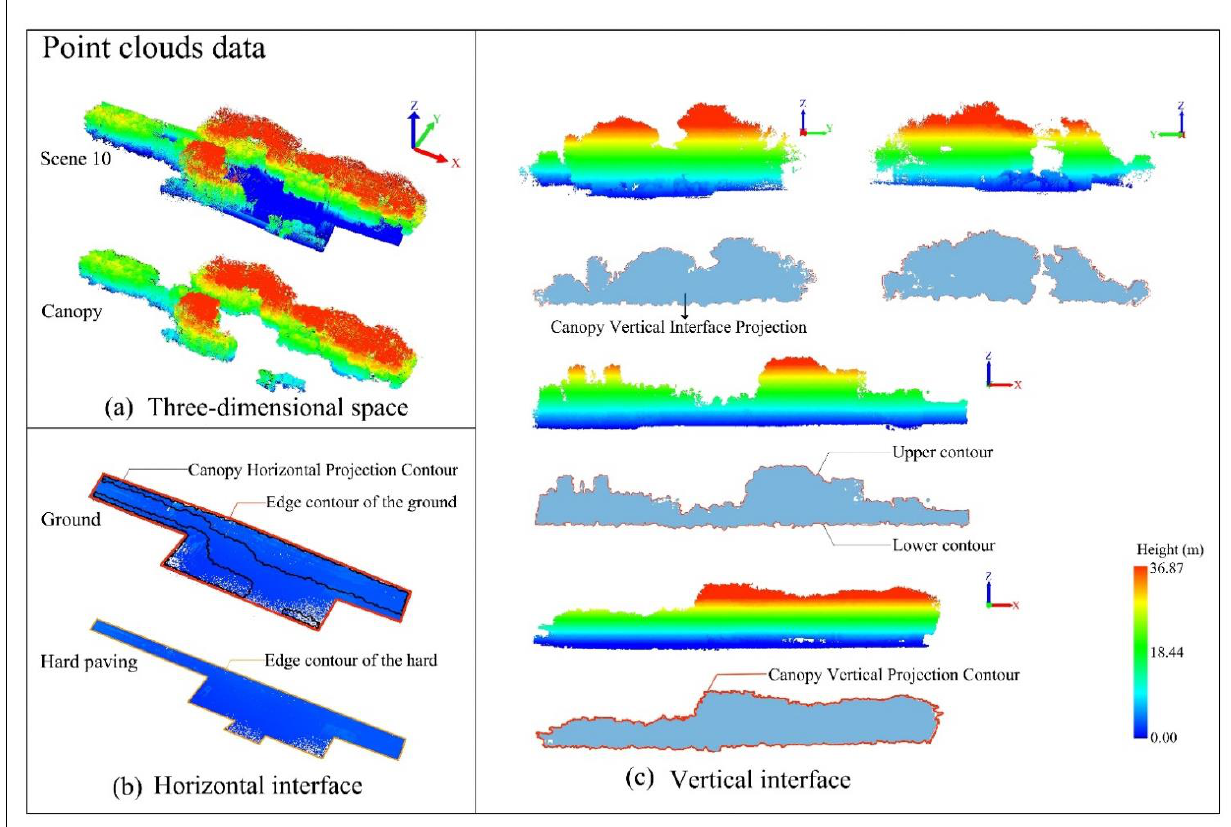
Figure 3. Schematic diagram of indicator calculation.